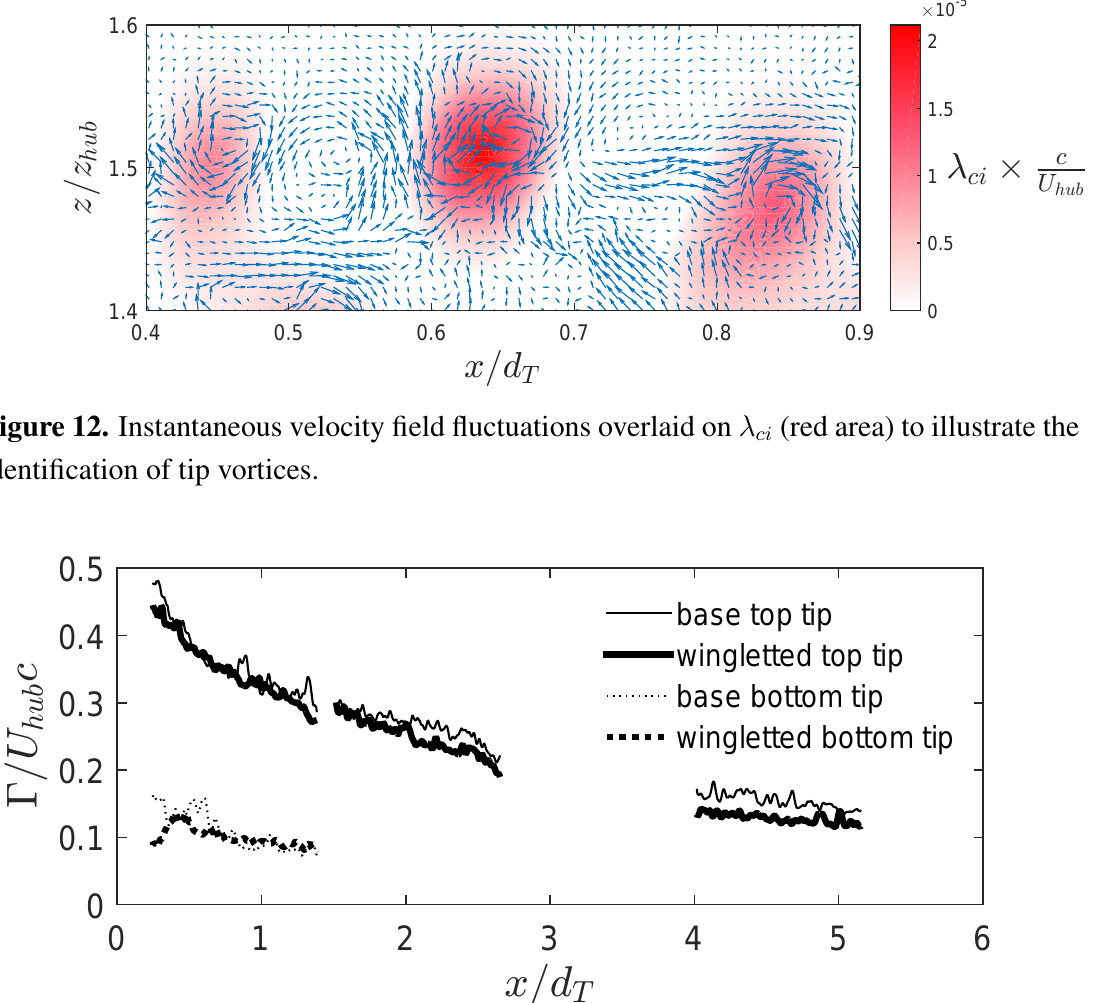
Figure 13. Average tip-vortex strength Γ as a function of the distance from the turbine for the standard and wingletted turbines.